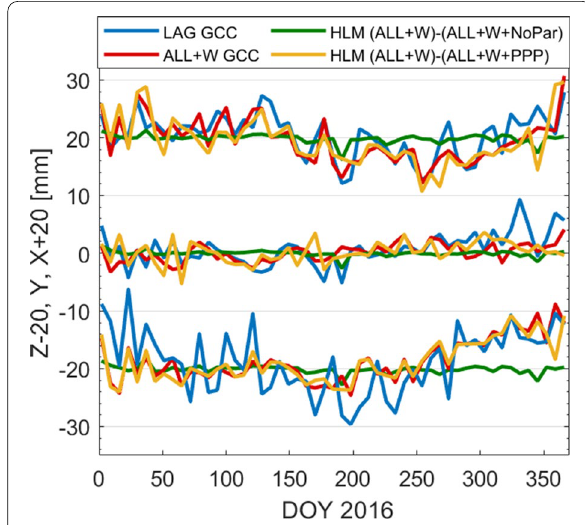
Fig. 15 Geocenter coordinates (GCC) from LAG and ALL solutions compared to the translation parameters of Helmert transformation (HLM) calculated between ALL ALL W NoPar, and between ALL + + We added 20 mm to the X geocenter and translation components and subtracted 20 mm from to the Z geocenter and translation components for